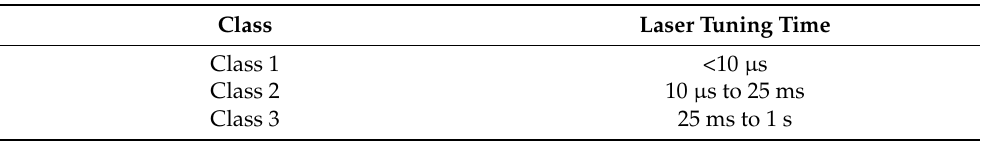
Table 1. Classes of Laser Tuning Time, according to ITU-T